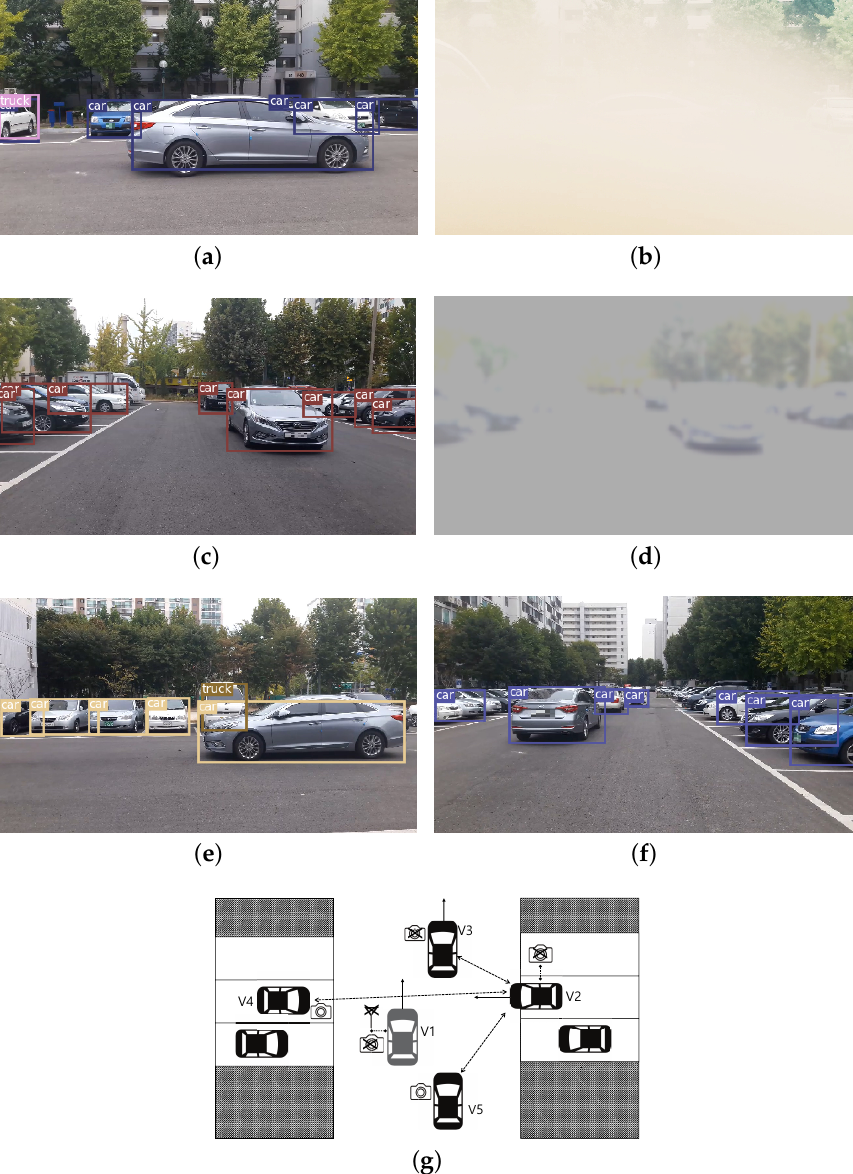
Figure 14. The video images captured at vehicles and detection results: ( a ) The original image at V2. ( b ) The blurred image at V2. ( c ) The original image at V3. ( d ) The blurred image at V4. ( e ) The front view of V4. ( f ) The front view of V5. ( g ) Top view